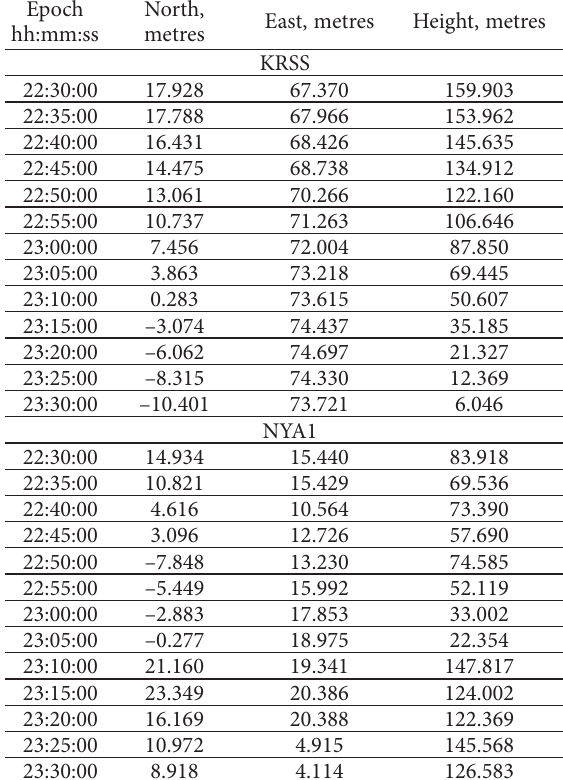
Table 2. The differences of CPOS stations in 2003